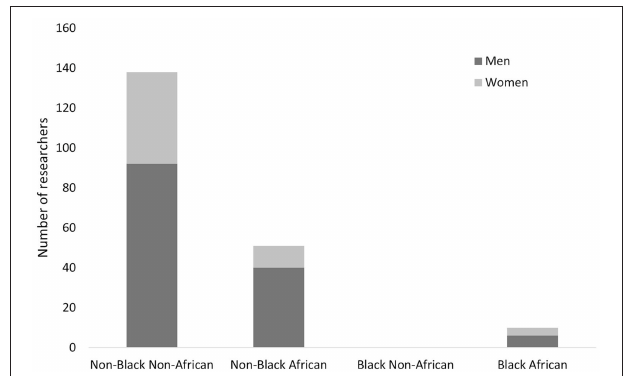
FIGURE 1 | Number of researchers with ≥ 3 papers on lions, by race, gender, and continent-aggregated nationality.